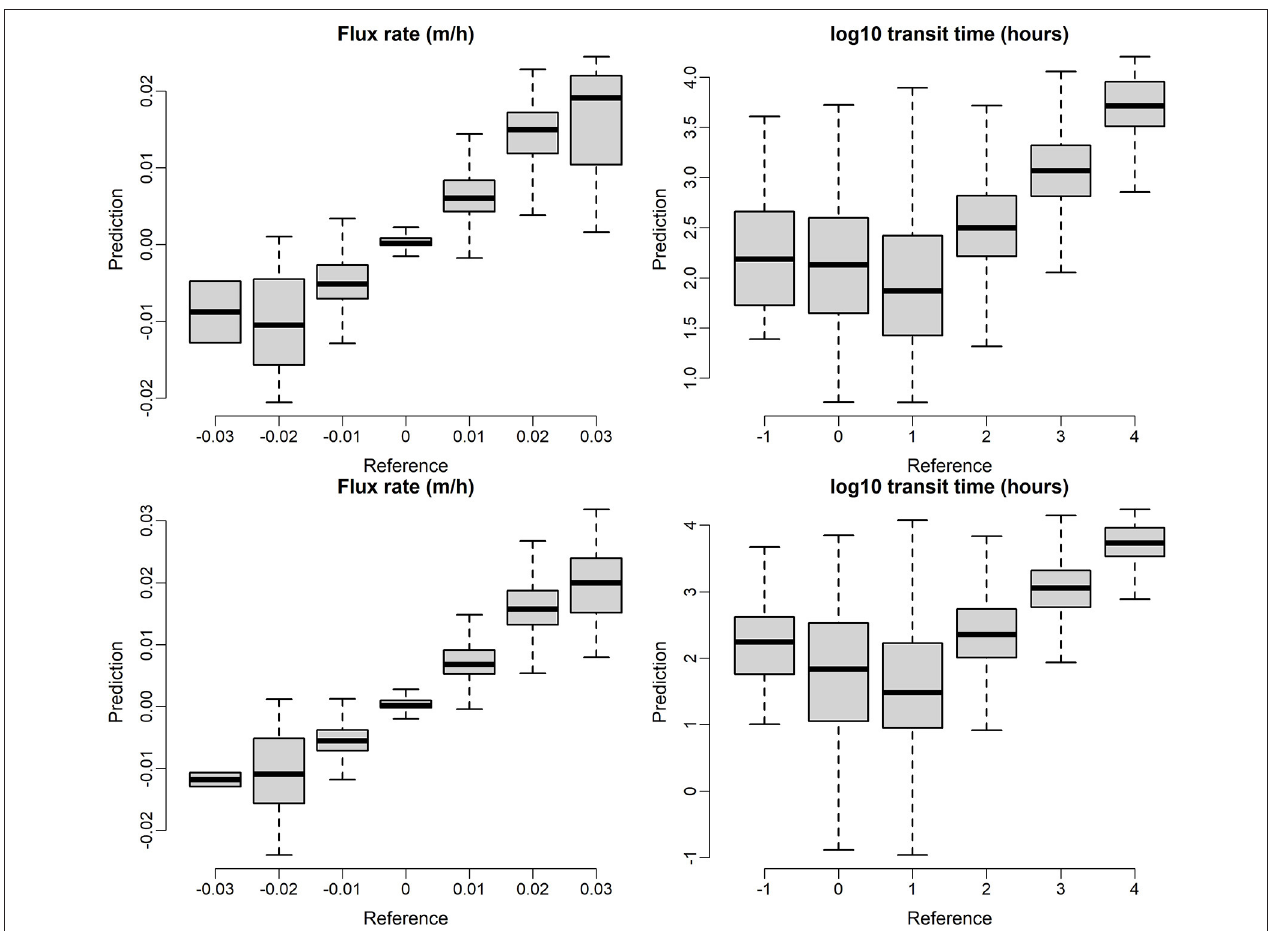
FIGURE 7 | ML model prediction on testing dataset, the top panel is based on RF models and the bottom panel is based on XGB